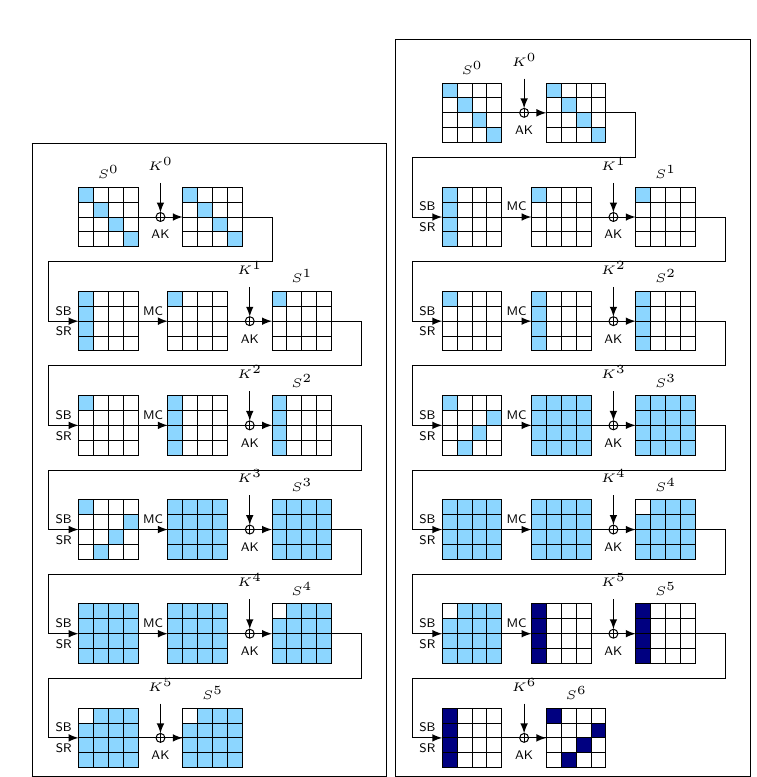
Figure 11: Multiple-of-four distinguisher on five-round Small- AES ( left ), and the key-recovery attack on six rounds ( right